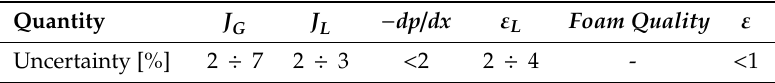
Table 4. Relative uncertainties of the main quantities.